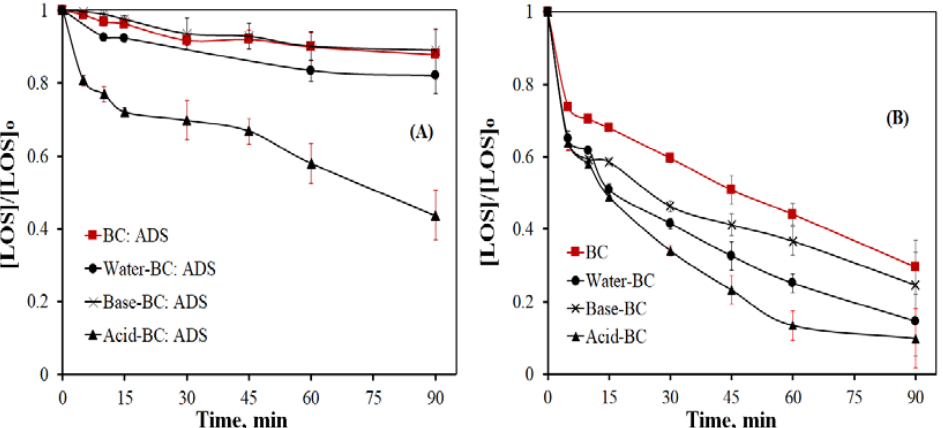
Figure 3. ( A ) LOS adsorption at inherent pH = 5.6 by untreated and treated biochar. ( B ) LOS degra ‐ dation at inherent pH = 5.6 by biochar/SPS process. Experimental conditions (LOS) = 250 μ g/L, (SPS) = 250 mg/L and (BC) = (water–BC) = (base–BC) = (acid–BC) = 90 mg/L in UPW. (SPS) = 250 mg/L and (BC) = (water–BC) = (base–BC) = (acid–BC) = 90 mg/L in